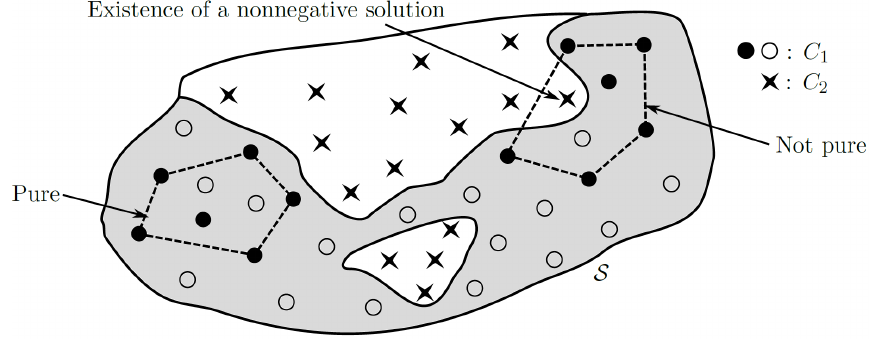
Figure 4. Illustration of the concept of pure sets on a binary classification